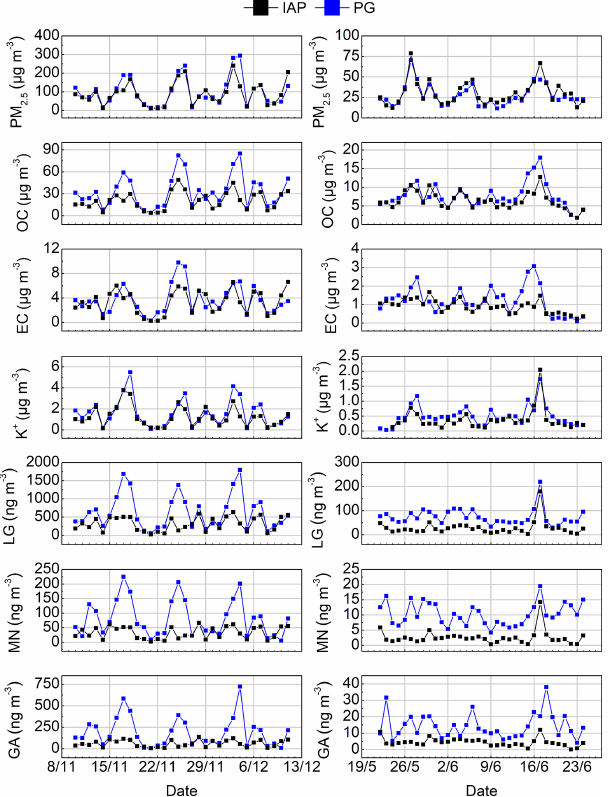
Figure 1. Time series of PM 2 . 5 and its major components at IAP and PG during winter (left) and summer